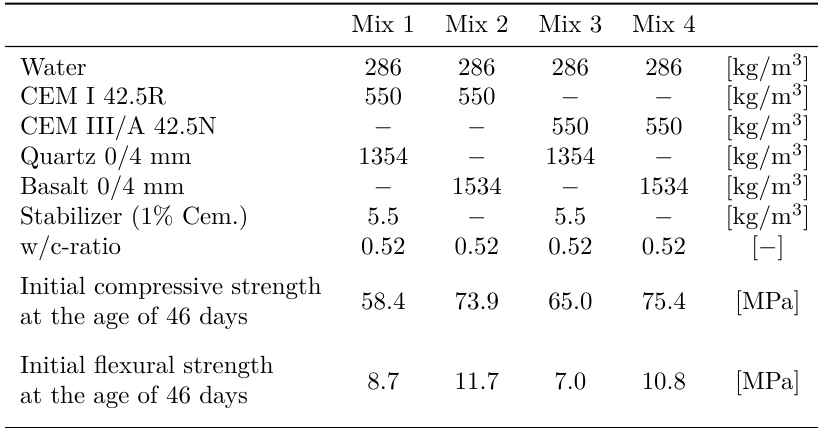
Table 1. Overview of concrete mixtures.